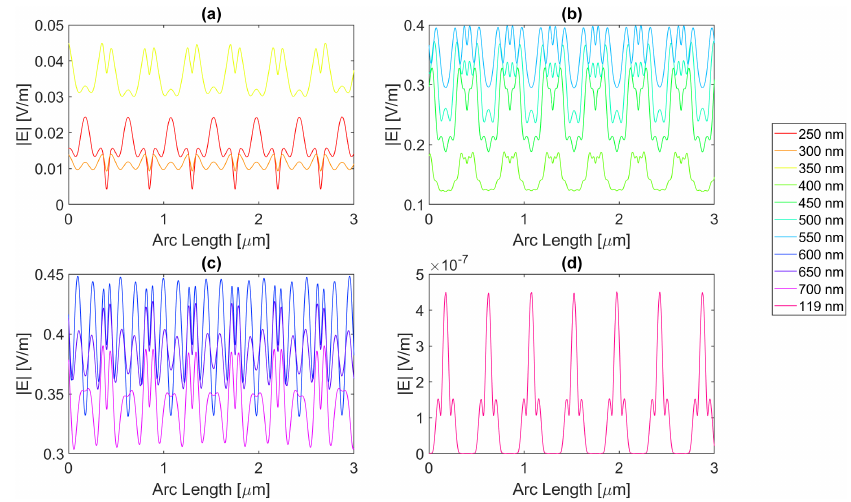
Figure 19. Electric field for the aluminium circular nanostructure with a 200 nm radius—Probe 1.